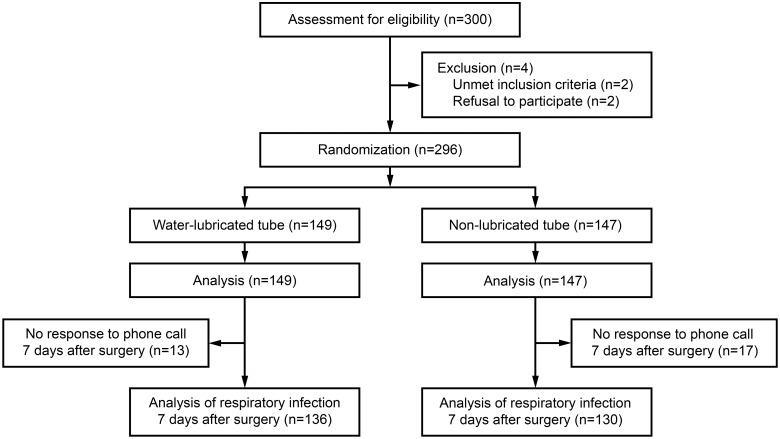
CONSORT flow diagram.At seven days after surgery, patients were asked by phone call whether they had respiratory infection since the surgery.